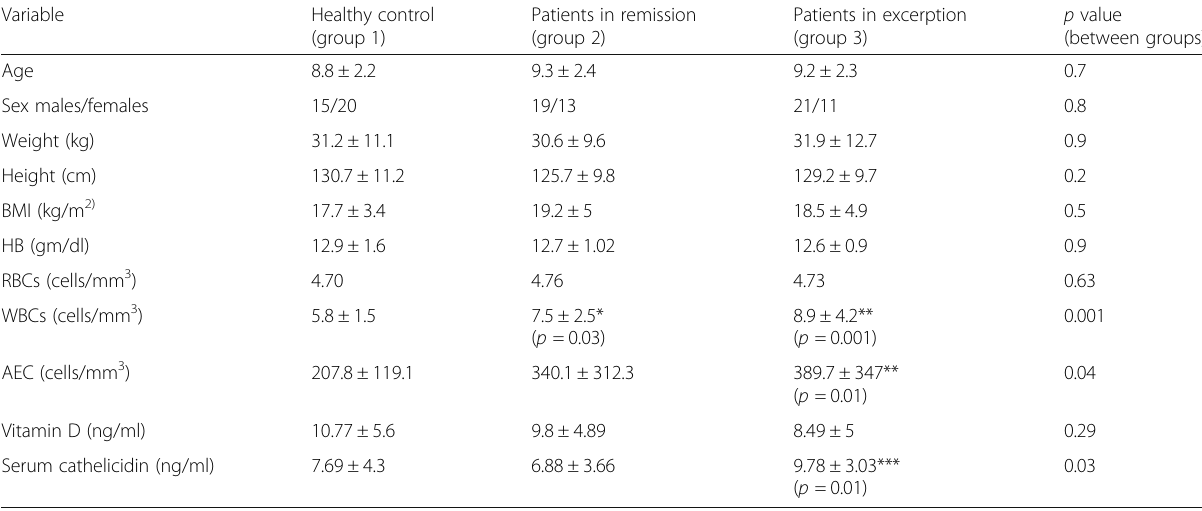
Table 2 Comparison between asthmatics and control regarding demographic and laboratory data